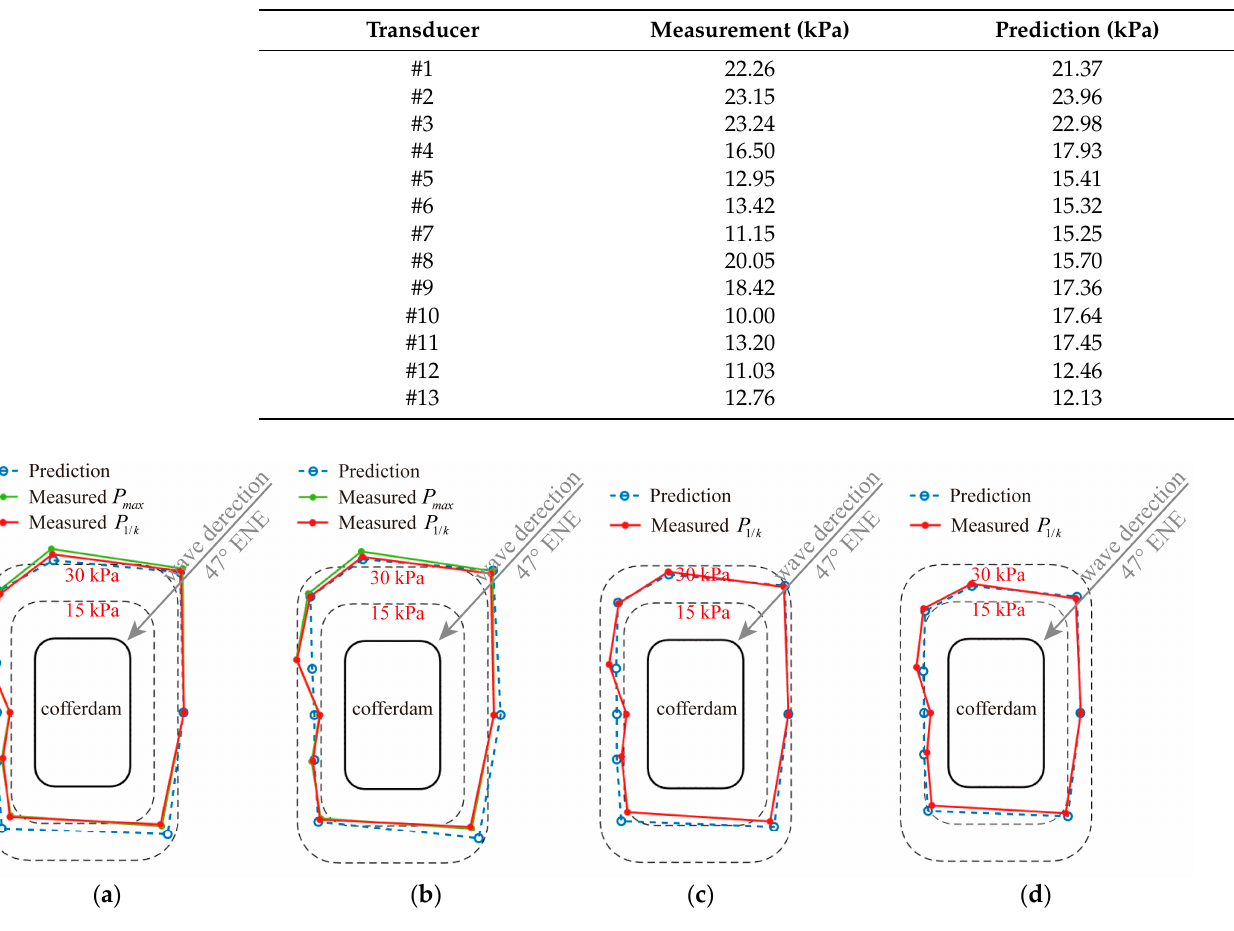
Table 4. Measurement ( P 1/3 ) and prediction ( H 1/3 , T 1/3 ).